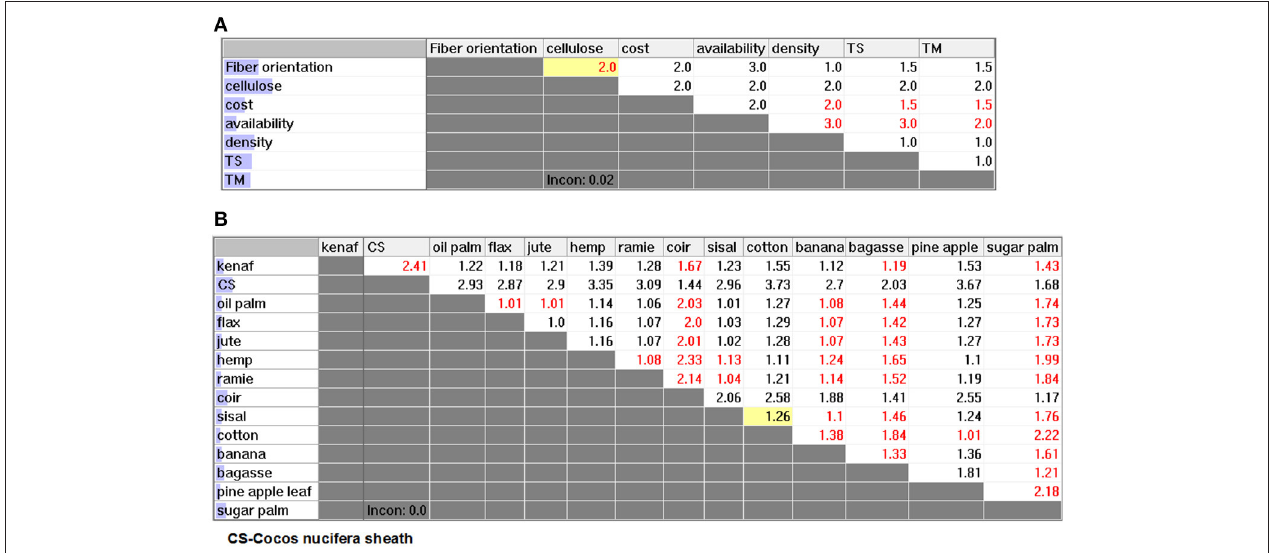
FIGURE 5 | (A) Pairwise comparison matrix of criteria. (B) Pairwise comparison matrix of alternatives with respect to